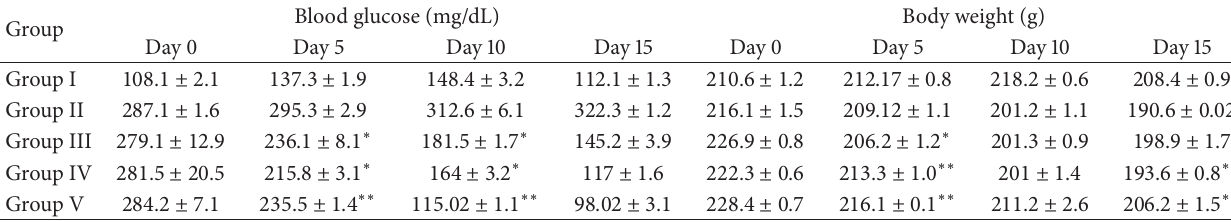
Table 1: Effect of Cestrum nocturnum on blood glucose and body